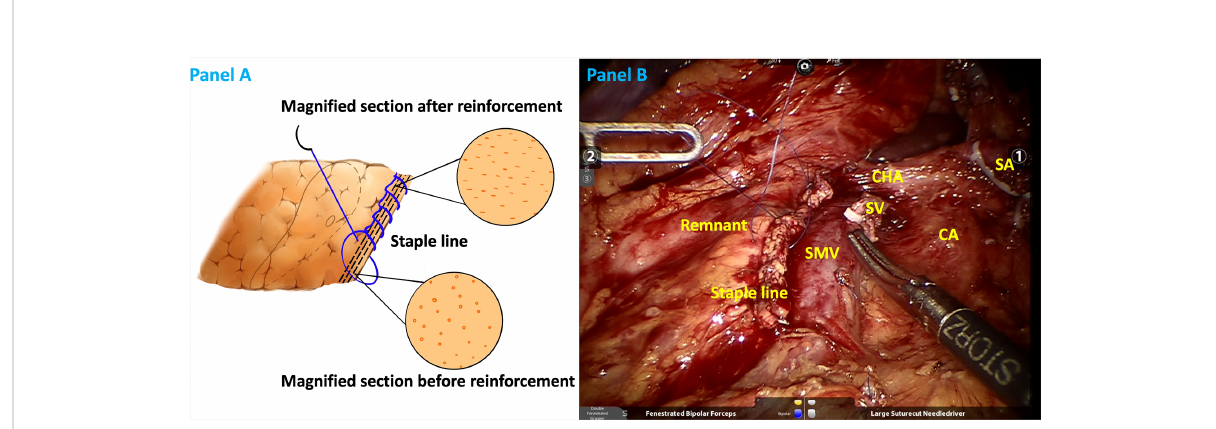
FIGURE 1 Illustrations of staple line reinforcement with continuous lock stitches in schematic (A) and realistic drawings (B) . SA splenic artery (ligated), CA celiac axis, CHA common hepatic artery, SV splenic vein (ligated), SMV superior mesentery